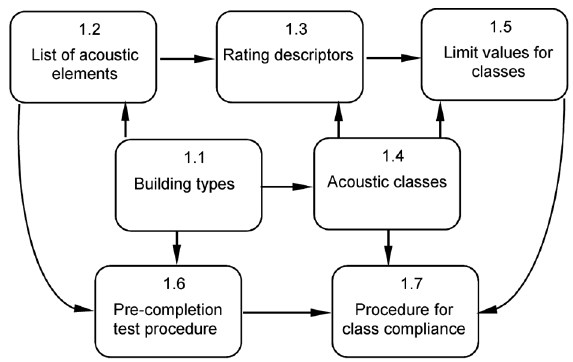
Fig. 1. Block-scheme explaining the development of sound classification scheme for buildings. Numbers in blocks corresponds to the SCS description given in this